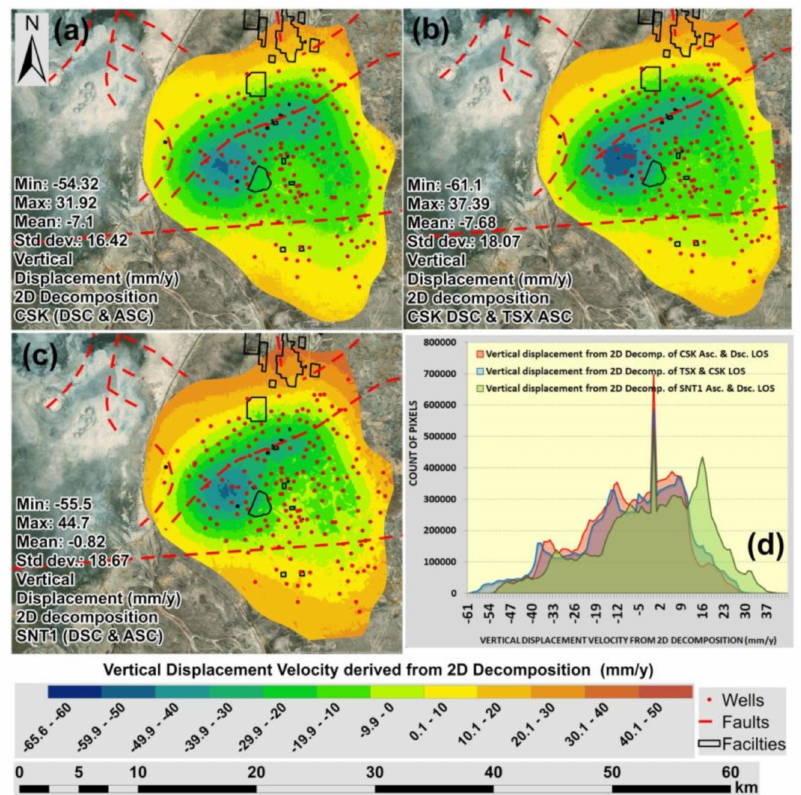
Figure 9. Maps of vertical displacement velocity (2018–2020) derived from 2D decompositions of: ( a ) CSK DSC/ASC Tracks; ( b ) CSK DSC/TSX ASC Tracks; ( c ) SNT1 DSC/SNT1 ASC Tracks; ( d ) Histograms of vertical displacements.